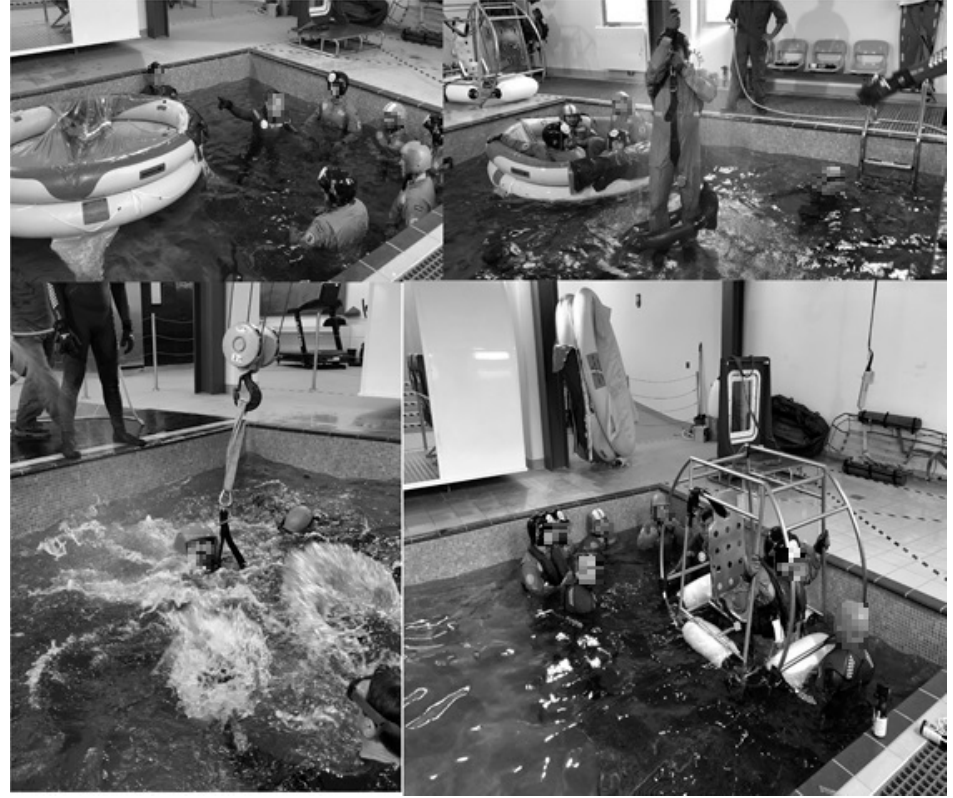
Figure 1. Four moments of the underwater evacuation training.